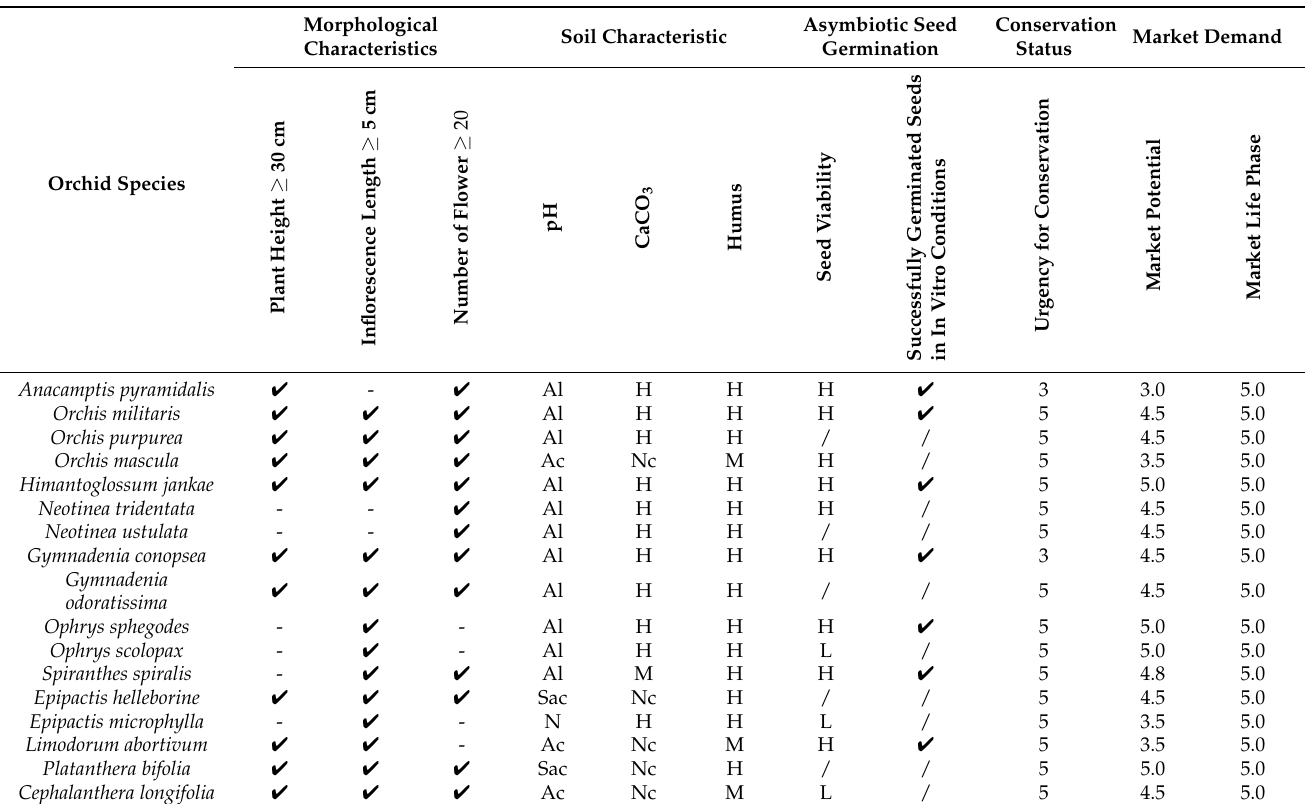
Table 2. Diversity analysis of terrestrial orchids of Fruška gora with multiple potential uses in